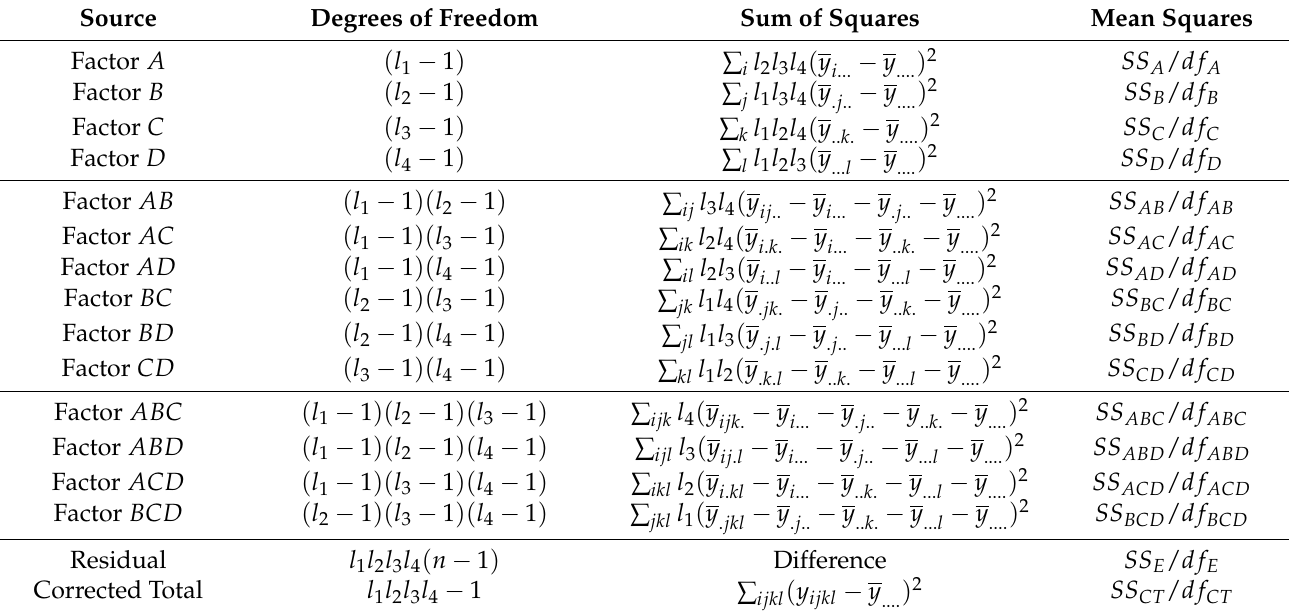
Table 3. ANOVA structure and equations for the four-factor full factorial design.